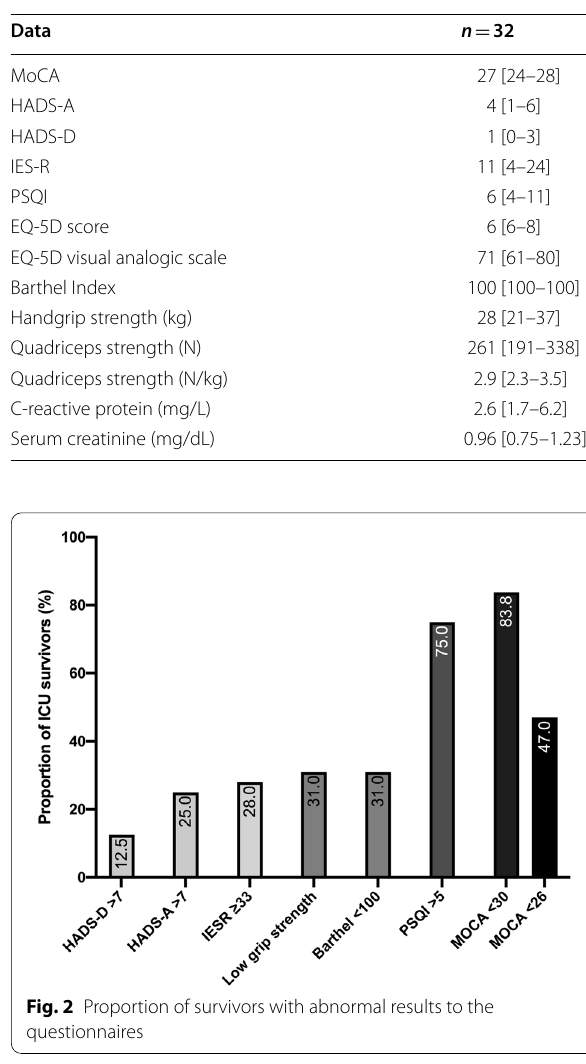
Table 2 M3 assessment